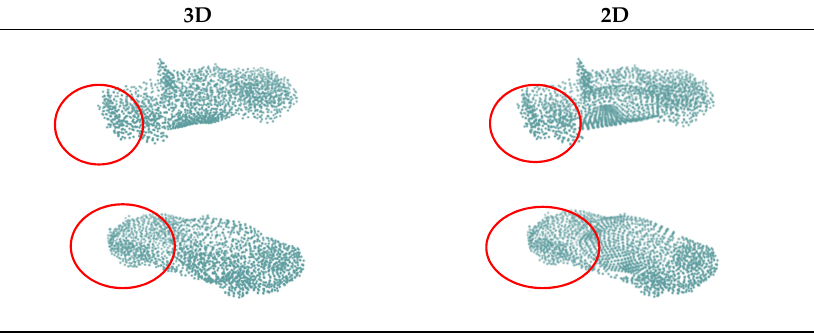
Figure 5. Comparison of using 3D versus 2D lattice.